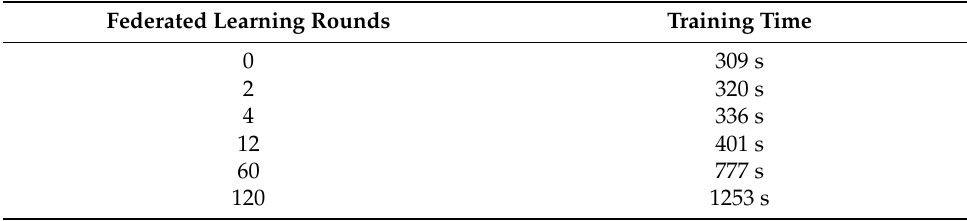
Table 1. Federated learning rounds vs. time for training 120 data